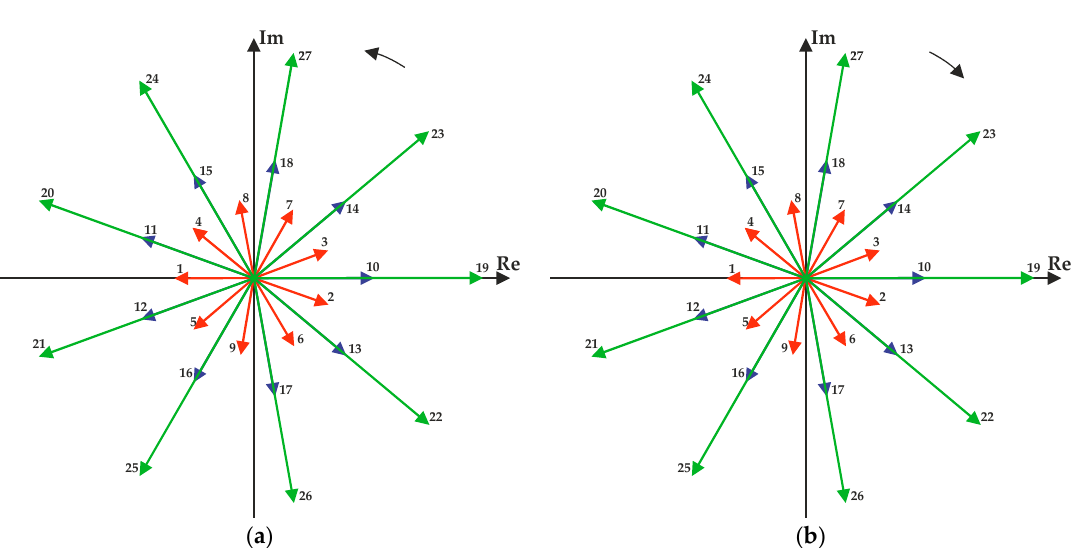
Figure 2. Initial arrangement on complex plane of rotating voltage space vectors that are used to eliminate the CMV in the three-to-nine-phase MC: ( a ) CCW; ( b ) CW.